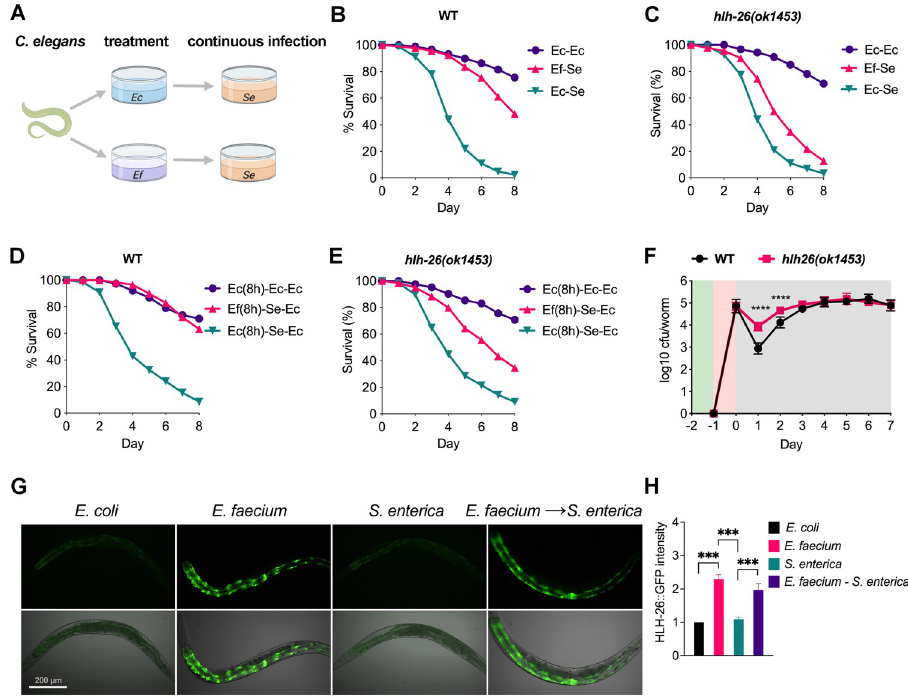
Fig 2. hlh-26 is required for probiotic E . faecium –mediated protection against S . enterica infection. (A) Schematic of a treatment-continuous S . enterica infection assay. Animals were treated for 1 day on BHI agar with E . faecium and then transferred to modified NGM agar (0.35% peptone instead of 0.25% peptone) for infection with S . enterica for the remainder of the assay, after which survival was scored. Survival curves assaying E . faecium –mediated protection with continuous S . enterica infection in (B) wild-type and (C) hlh-26(ok1453) animals. Survival curves assaying 8 h of E . faecium protection in (D) wild-type and (E) hlh-26(ok1453) animals. Survival curves are representative assays of 3 independent experiments. n = 60 to 90. (F) S . enterica CFU measured after infection in wild-type and hlh-26(ok1453) animals. Data points represent average CFU ± SD. n = 6 animals; N = 3 biological replicates. ���� P < 0.0001. The background shading represents the stage of the treatment–infection assay. Green indicates treatment, red indicates infection, and gray indicates E . coli OP50 feeding. (G) Fluorescence micrographs of animals expressing GFP fused to HLH-26 (HLH-26::GFP) after an 8-h exposure to E . coli , E . faecium , S . enterica , or 24-h exposure to E . faecium followed by 8-h exposure to S . enterica . (H) Quantification of the animals shown in (G), N = 3 biological replicates. ��� P < 0.001. The data underlying all the graphs shown in the figure can be found in S1 Data. CFU, colony-forming unit; Ec, E . coli OP50; Ef, E . faecium ; kEc, heat-killed E . coli OP50; NGM, nematode growth medium; Se, S . enterica ; WT, wild-type.